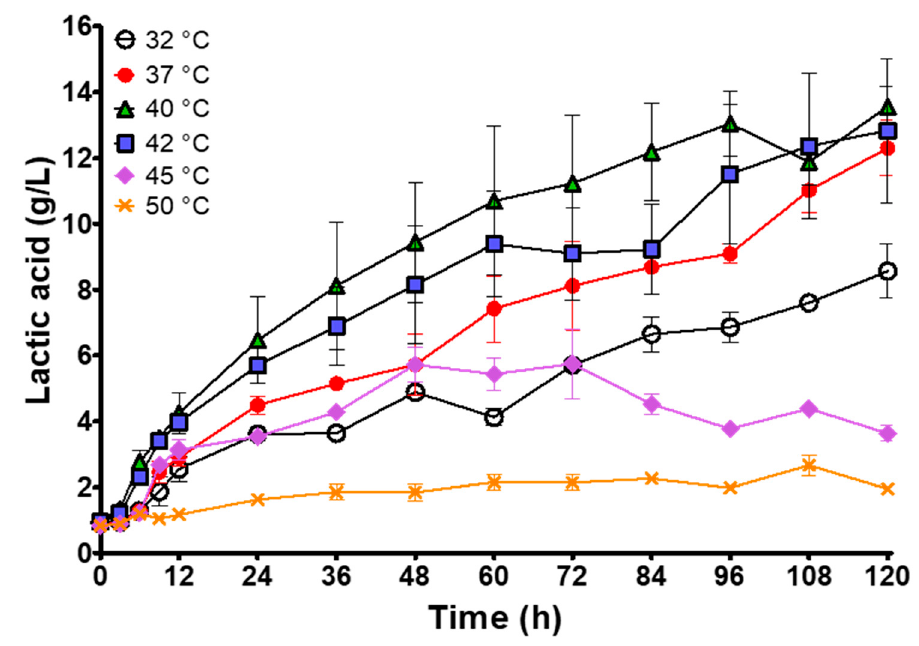
Figure 2. Temperature effect on the production of lactic acid (g/L) during spontaneous fermentation of whey by its native microbiota. Values are expressed as mean ± SD, n = 6.